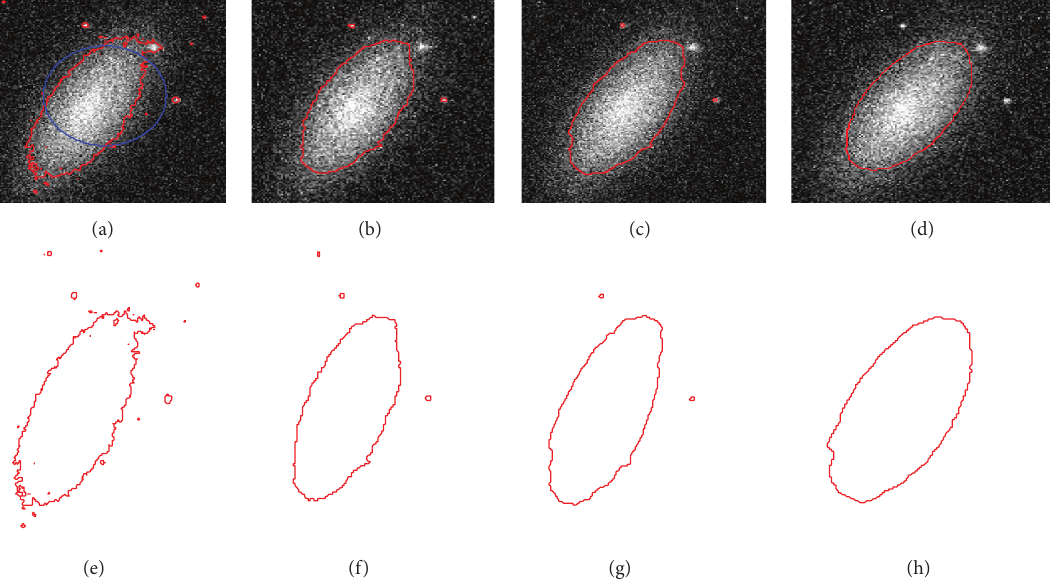
Figure 4: Segmental results of a galaxy image with Gaussian variance 0.1. (a) Segmental result with CV model and the blue curve is the initial contour ( 𝜇 0 = 0.04∗255∗255 ). (b) Segmental result with TV-based segmentation model. (c) Segmental result with adaptive TV-based model. (d) Anisotropic diffusion-based segmentation model. (e), (f), (g), and (h) are the corresponding contours to (a), (b), (c), and (d),